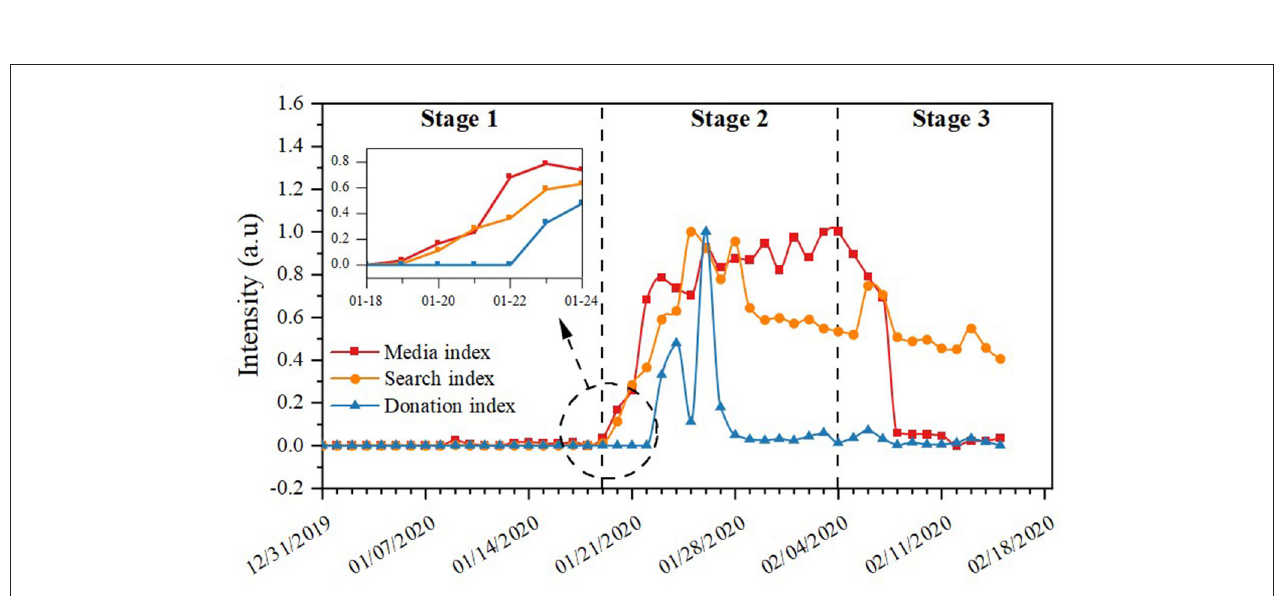
FIGURE 3 | Mechanism of public participation, the attention of new media and the response of the central government in central-local interactions.